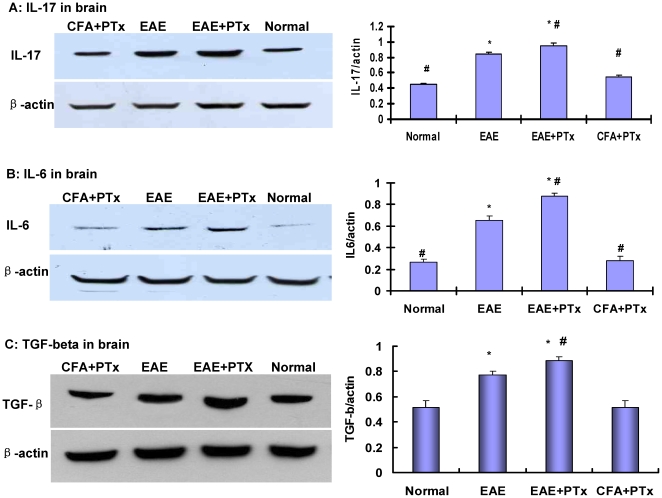
The western blot depicts measures of IL17 (A), IL6 (B) and TGF-β (C) in the brain of EAE +PTx icv compared with in EAE alone mice as well as controls.Statistical evaluation of optic density (OD) normalized to β-actin was obtained. Mean +/− SD are depicted (n = 6 per group). *P<0.05, compared with normal control group; #P<0.05, compared with EAE group.